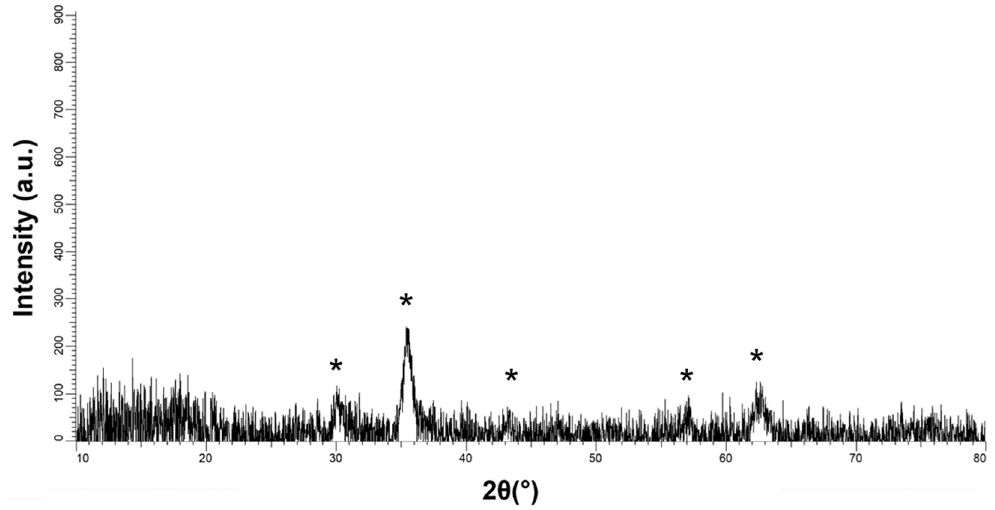
Figure 1. XRD diffractogram of MNPs (Fe 3 O 4 -PEG/PLGA). * = magnetite (JCPDS card n. 19-0629).